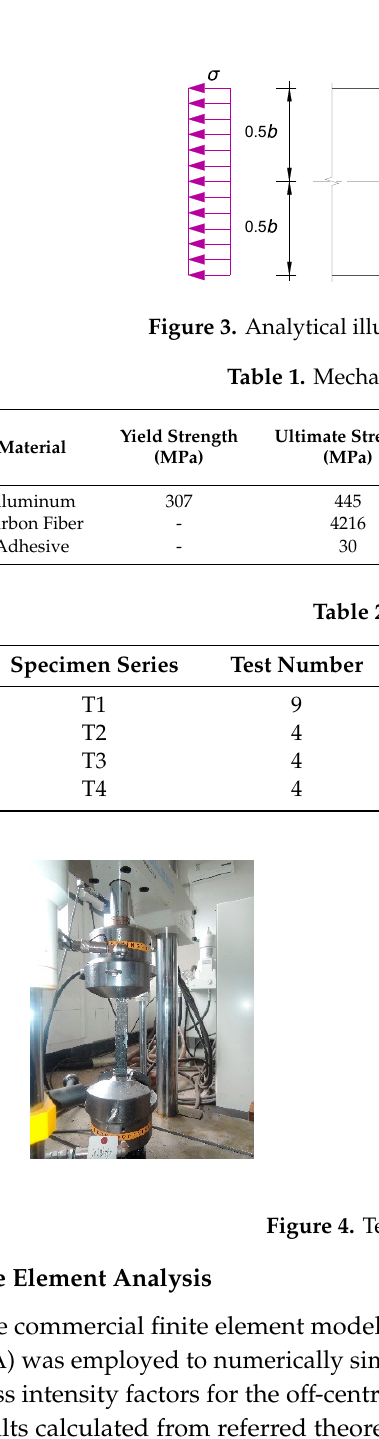
Table 2. List of test specimens.